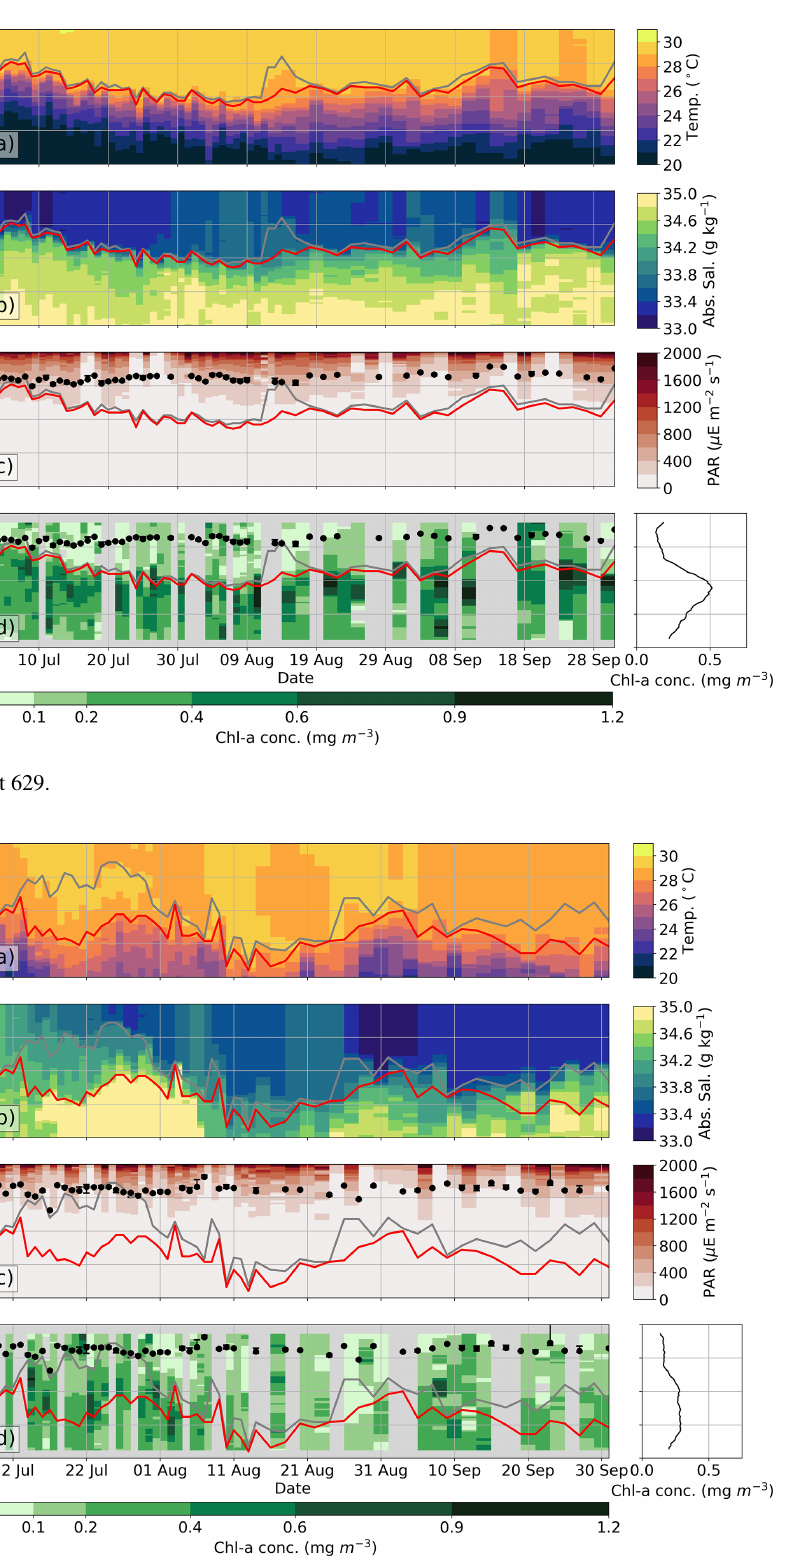
Figure 8. As Fig. 6 but for float